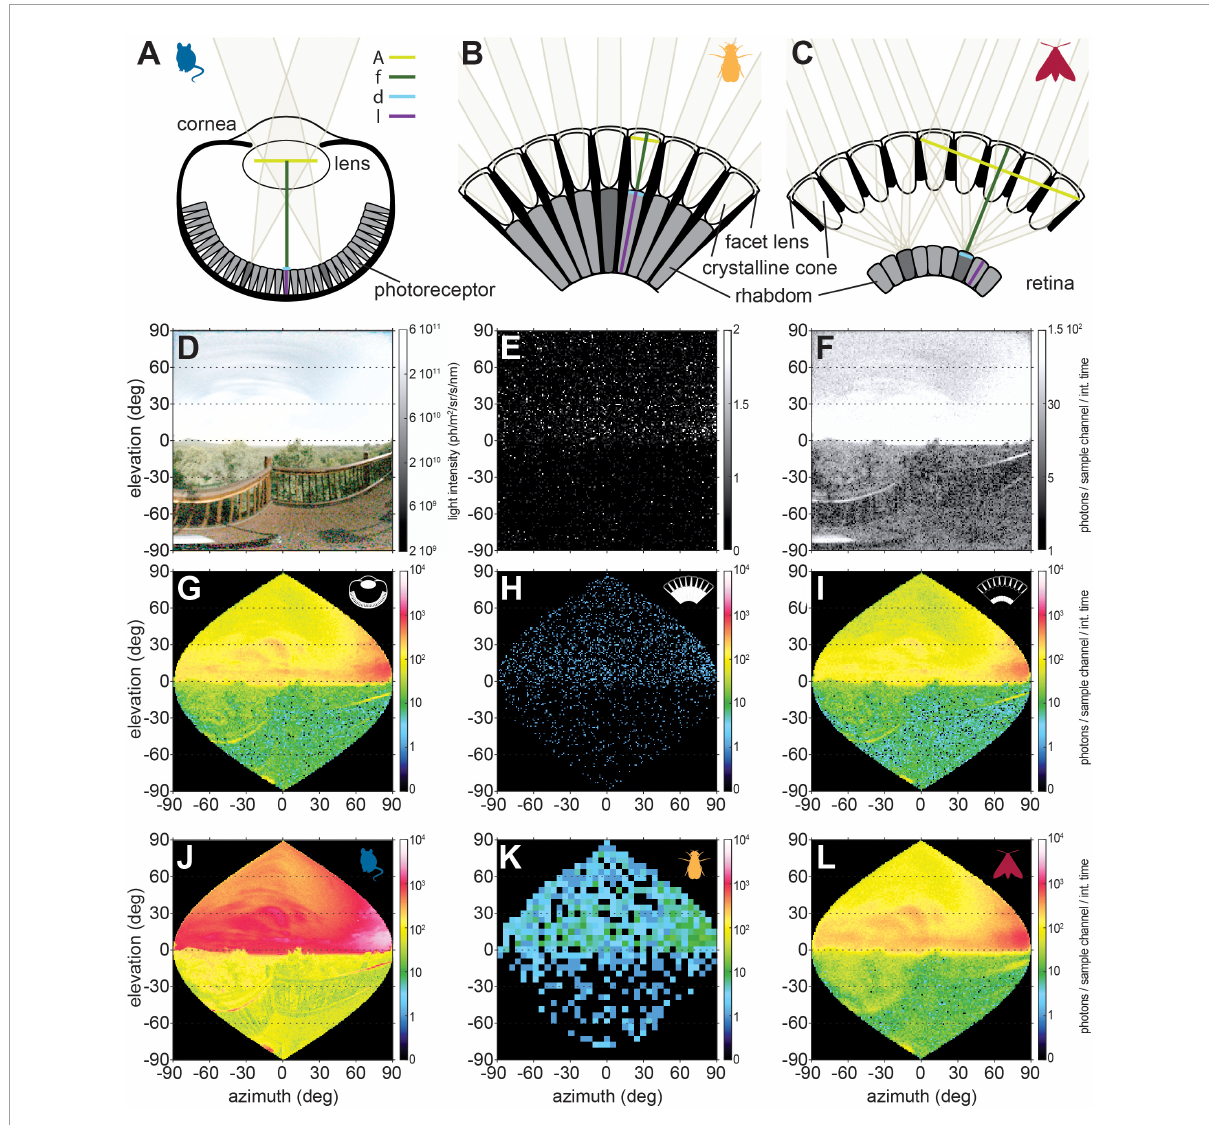
FIGURE3 The three most common eye designs in animals. (A) In a camera eye, light is focused by the cornea and lens on to the photoreceptors in the retina. This eye design is found in all vertebrates and is also common in the main eyes of molluscs and arachnids. A , f , d , l correspond to Eq. 3. (B) Apposition compound eyes are made of repeating units, the ommatidia, which are comprised of a facet lens, crystalline cone and the a group of photoreceptors, the retinula. The retinula cells of all ommatidia form the retina. Light is focused by the cornea and crystalline cone of each ommatidium onto the underlying rhabdom, the photosensitive tissue of the retinula cells. In a classical apposition eye, each ommatidium thus constitutes a sampling unit that views a “pixel” of the image. This eye design is commonly found in diurnal insects. (C) In superposition compound eyes, light is focused by the corneas and crystalline cones of a large number of ommatidia across the clear zone (cz) onto one rhabdom. Therefore, this eye design is typical for nocturnal insects, which require improvements in relative photon catch. (D) Nocturnal scene at moonlight recorded by the camera. Photon count of this scene simulated for (E) an apposition, and (F) a superposition compound eye [photon count is similar to the camera eye, compare panels (G,I) ]. All eye types were modeled with photoreceptors of the same width and length, the same spatial resolution (for both the visual angle covered by sampling units, and for the photoreceptor acceptance angle), the same effective apertures for camera and superposition eye, as well as the same facet aperture in both compound eyes (see Table 1 for parameters). The noise levels include photon shot and transducer noise of the same magnitude. (G–I) Pixels were resampled to represent the spatial sampling units of a perfectly spherical eye. (J–L) The same scene viewed through the eye of a mouse, fruit fly, and elephant hawkmoth (see Table 1 for parameters).